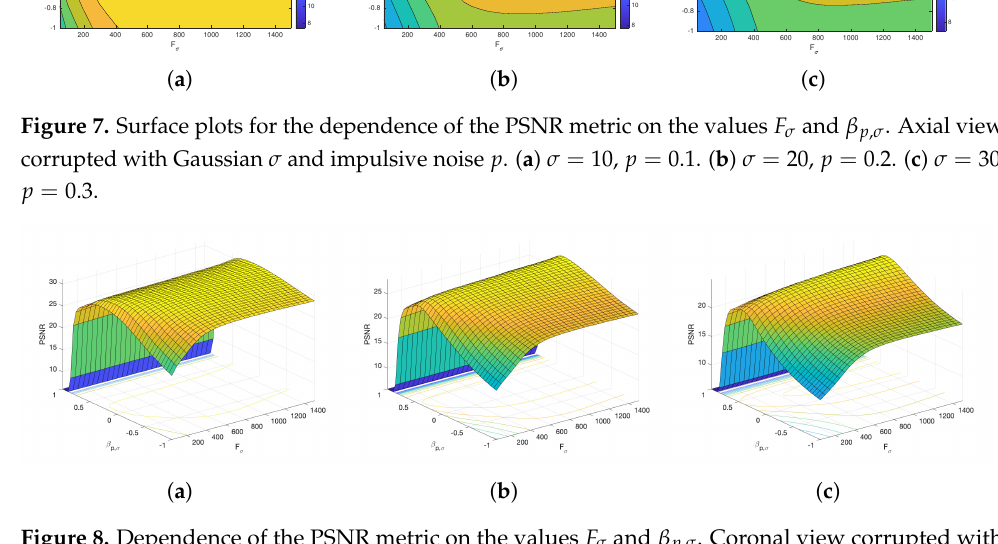
Figure 8. Dependence of the PSNR metric on the values F σ and β p , σ . Coronal view corrupted with Gaussian σ and impulsive noise p . ( a ) σ = 10, p = 0.1. ( b ) σ = 20, p = 0.2. ( c ) σ = 30, p =